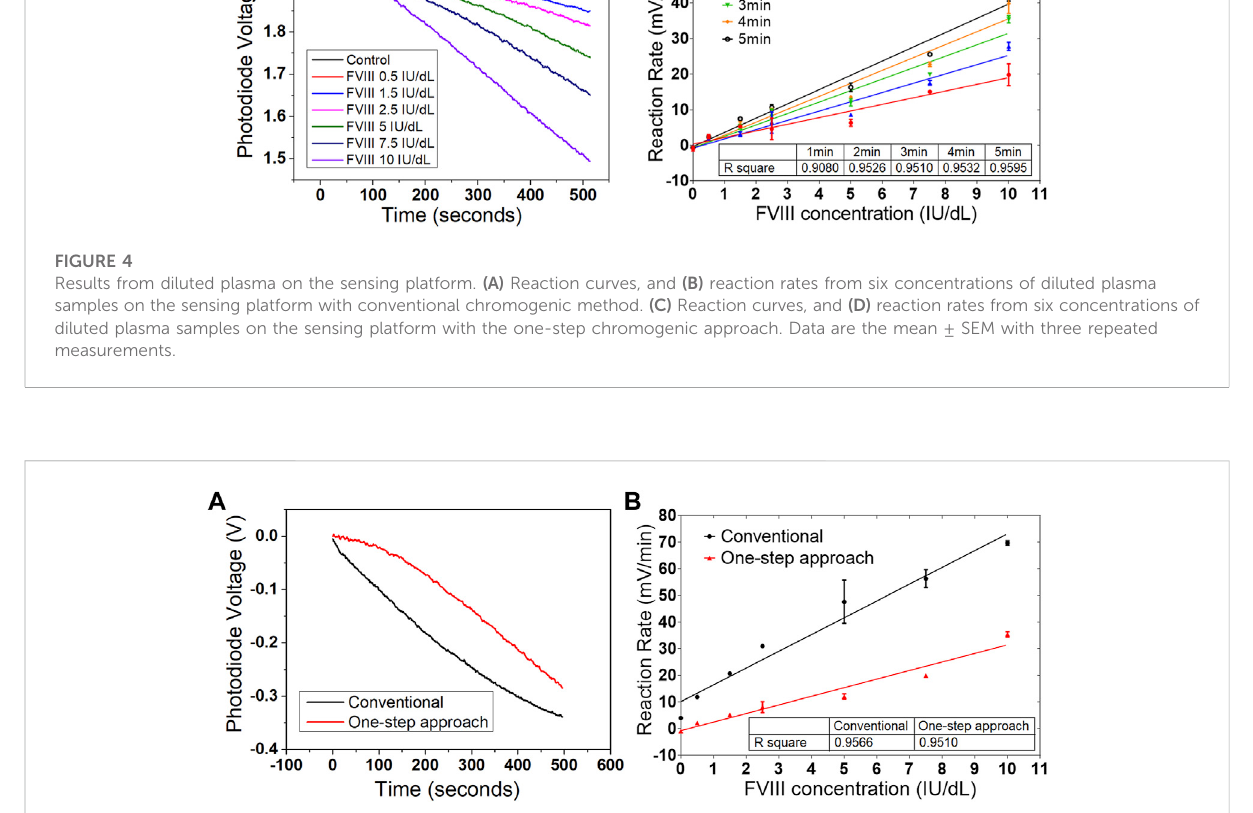
FIGURE 5 Comparison of the two chromogenic approaches on the sensing platform. (A) Reaction curves from both conventional and one-step approaches with diluted plasma containing 10 IU/dl Factor VIII. The difference on the waveform is obvious, but reasonable. (B) Reaction rates from both conventional and one-step approaches. The reaction rate from the one-step approach is slower, but with comparable linearity and sensitivity. Data are the mean ± SEM with three repeated